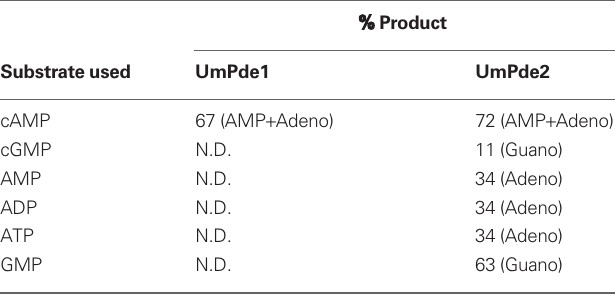
tabulated for comparison. Activity in vector alone sample was subtracted as background activity.